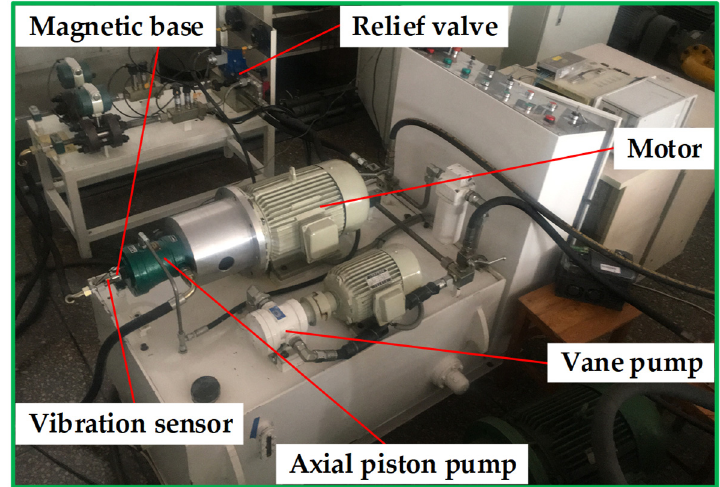
Figure 5. Degradation test bench of axial piston pump.